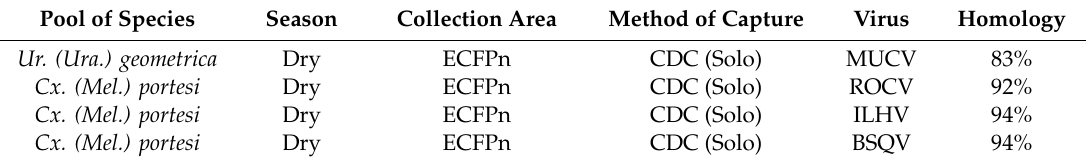
Table 1. Samples positive for the presence of viral genome from pools of mosquitoes collected at Floresta Nacional de Caxiuan ã , in the period of 2014 to 2016. Pool of Species Season Collection Area Method of Capture Virus Homology Ur. (Ura.) geometrica Dry ECFPn CDC (Solo) MUCV 83% Dry ECFPn CDC (Solo)